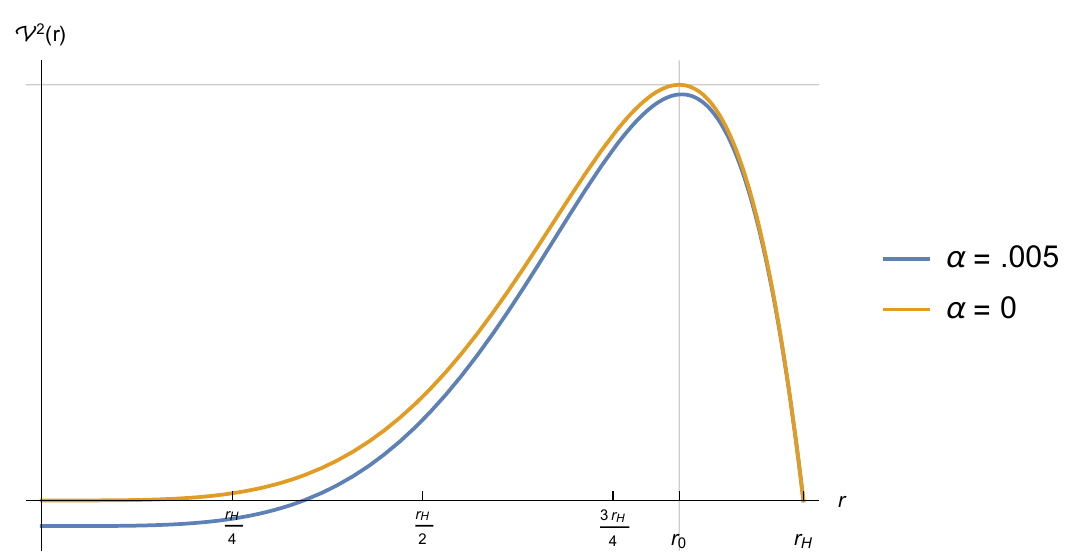
2 ( r ) of the volume functional for both the α -corrected AdS-Schwarzschild Figure 7. The square V geometry and the uncorrected geometry. We can see immediately that the α (cid:31) correction reduces the complexification rate, as